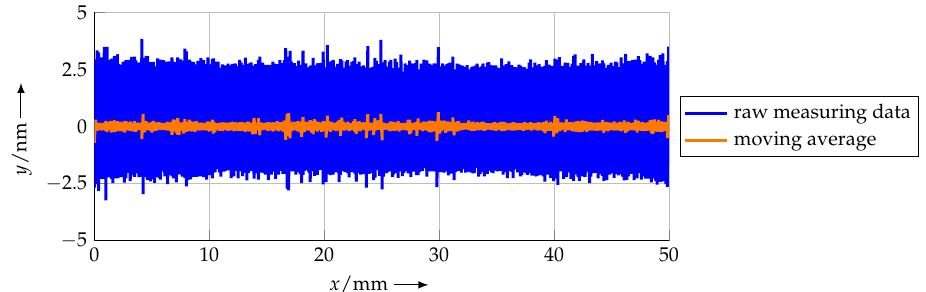
Figure 3. Signals of the x and y interferometer during linescan with a velocity of 20µms −1 over a length of 50mm driven by the machine table of the NFM-100, which shows the deviation of a straight line.